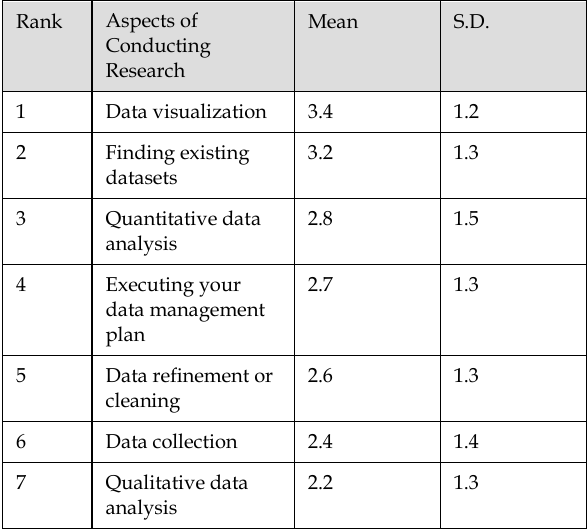
Table 3 Data-related conducting stage processes ranked by level of perceived